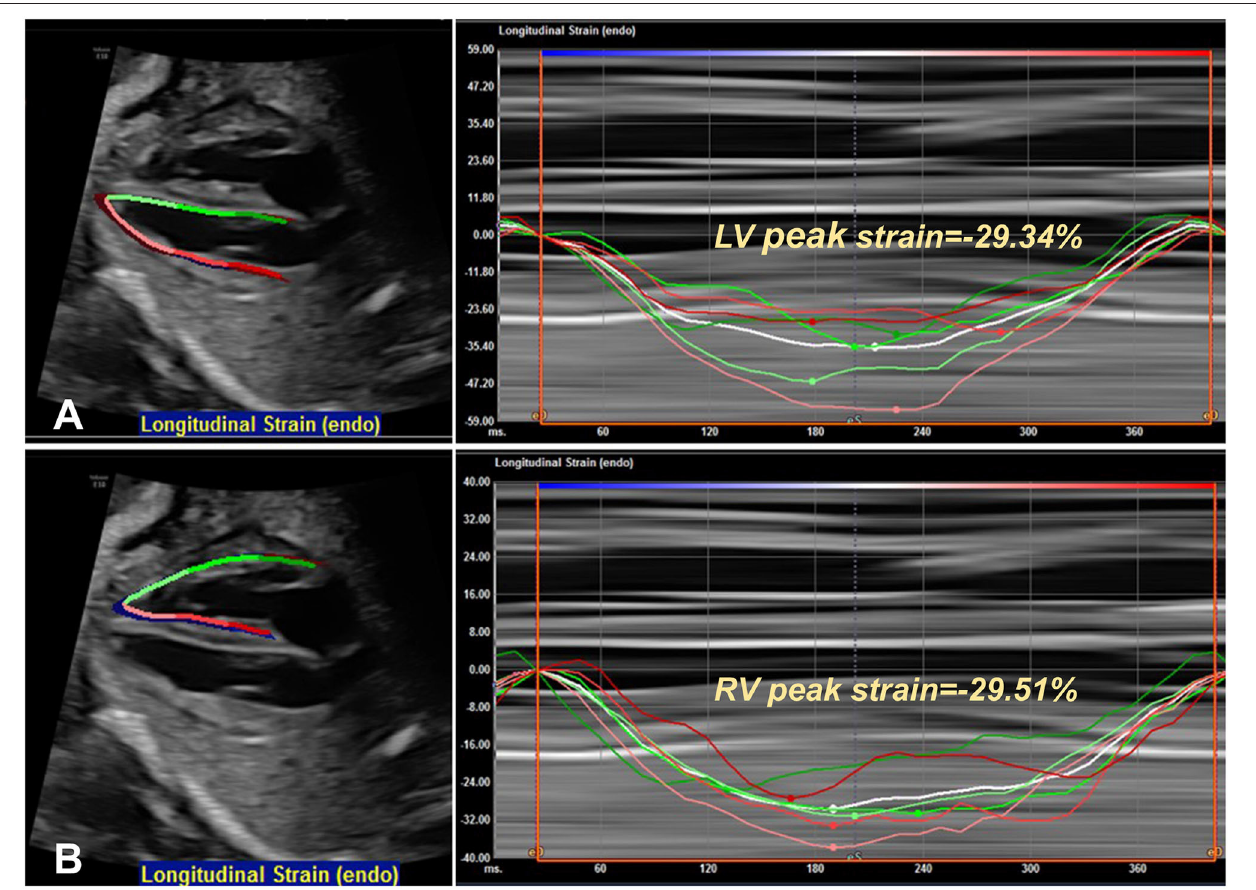
FIGURE 1 | An example of left (A) and right (B) ventricular deformation by speckle-tracking analysis in one fetus at 26-week gestation. In this case, the peak strain of the left ventricle is − 29.34%, and the right ventricle is −